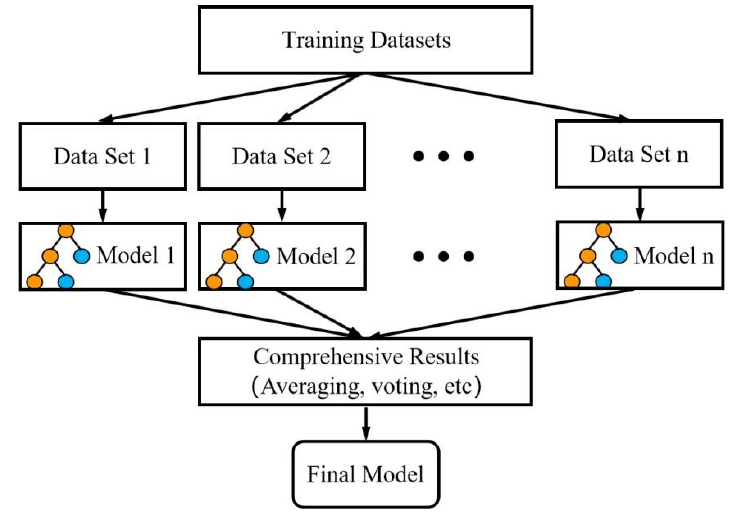
Figure 5. Basic structure of random forest.